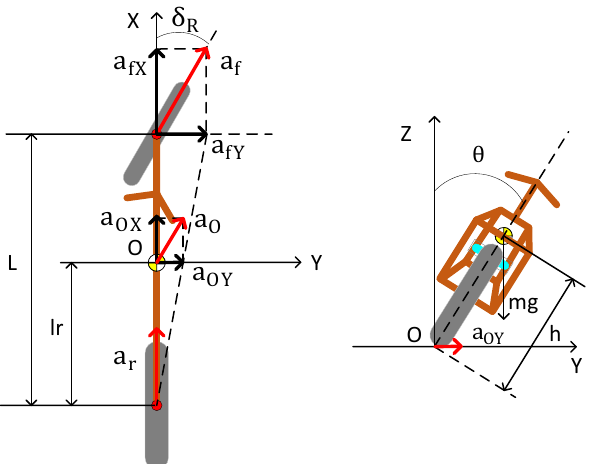
Figure 5. Schematic diagram of hub line acceleration ( left ) and the resulting lateral acceleration ( right ).